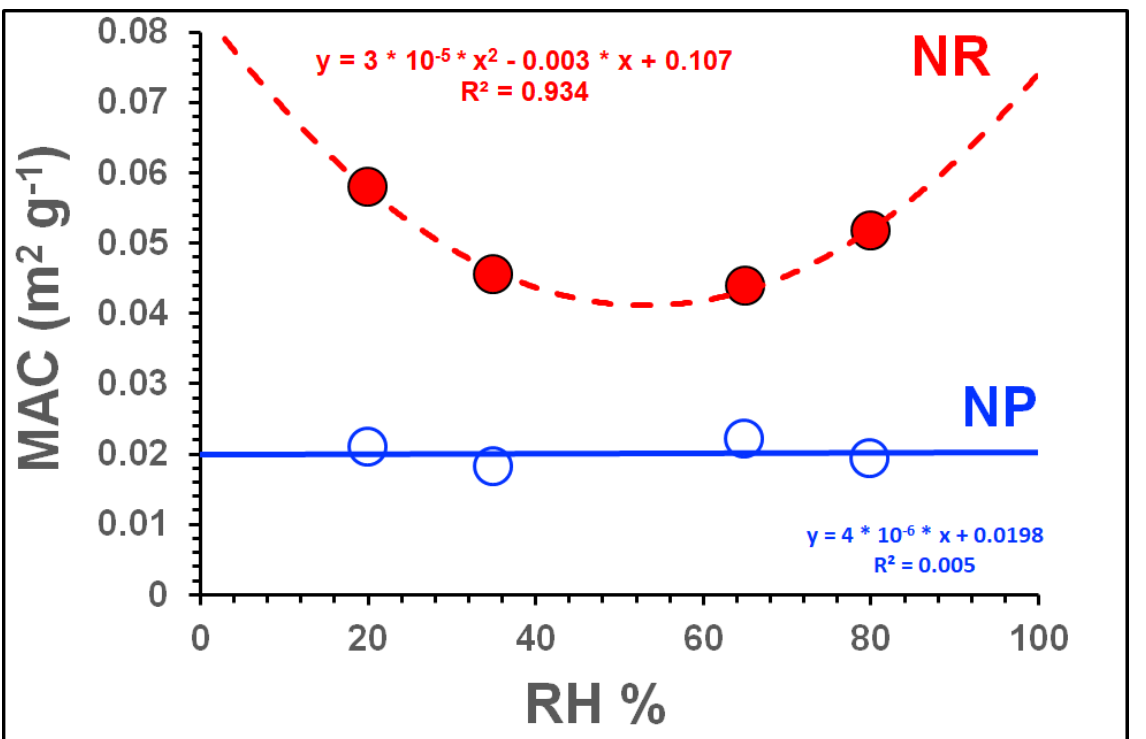
Figure 5. MAC as a function of RH in the NP and NR SOA formation regimes. Results for the NP and NR regimes are plotted using empty blue and filled red circles, respectively. Solid and dashed lines are included to guide the eye. Table 3. SOA Properties under various experimental conditions in the NP and NR regimes.